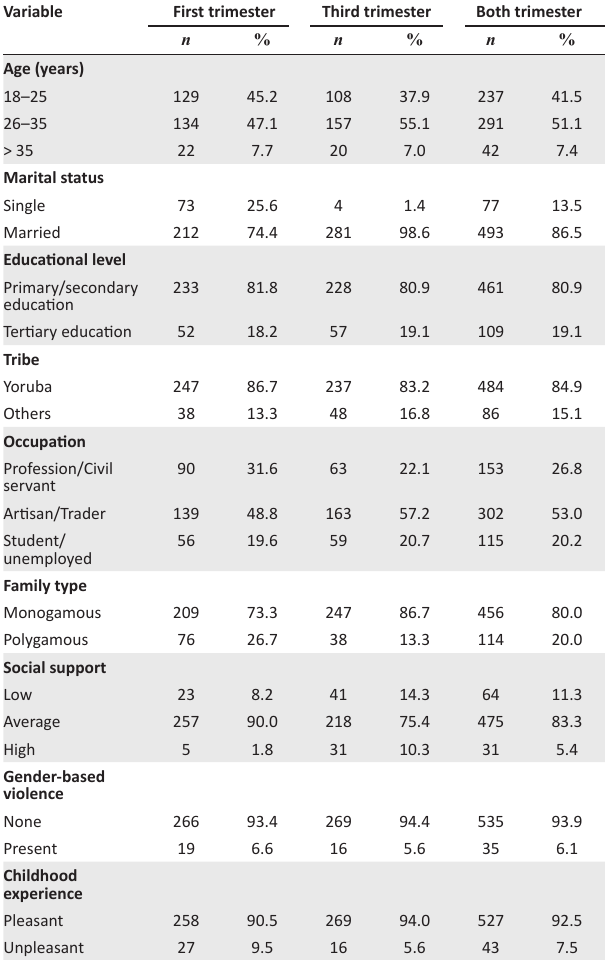
TABLE 1: Sociodemographic characteristics. Variable